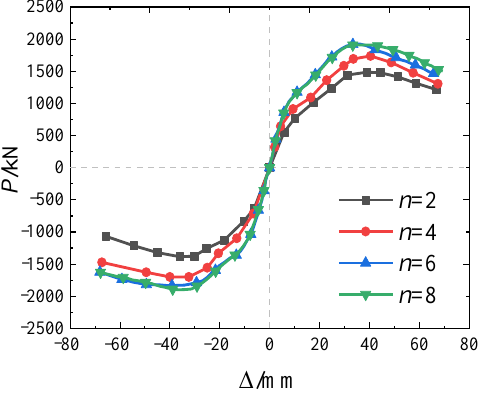
Figure 21. Load – displacement skeleton curves for models with different numbers of RCFSTKs. Figure 21. Load–displacement skeleton curves for models with different numbers of